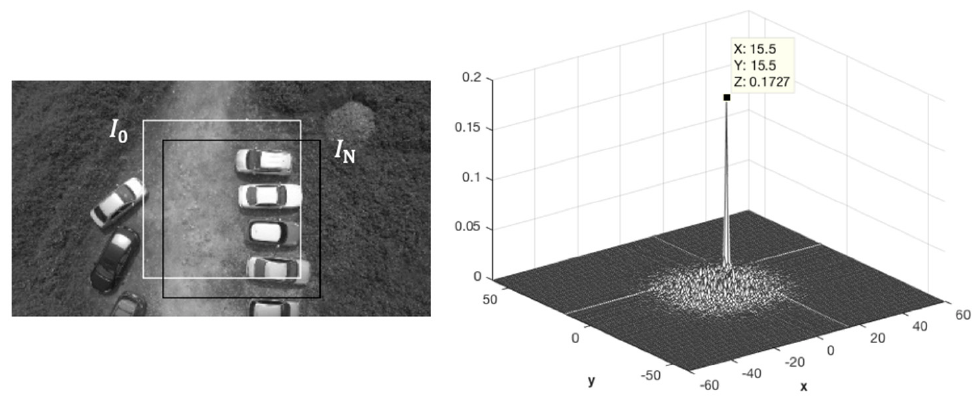
Figure 4. An example of the displacement-finding using the phase correlation method: two source images are cropped from the selected area ( left ), and the resulting peak on the correlation plot ( right ). The typical PC algorithm only allows a small range of scale variance between the two images.